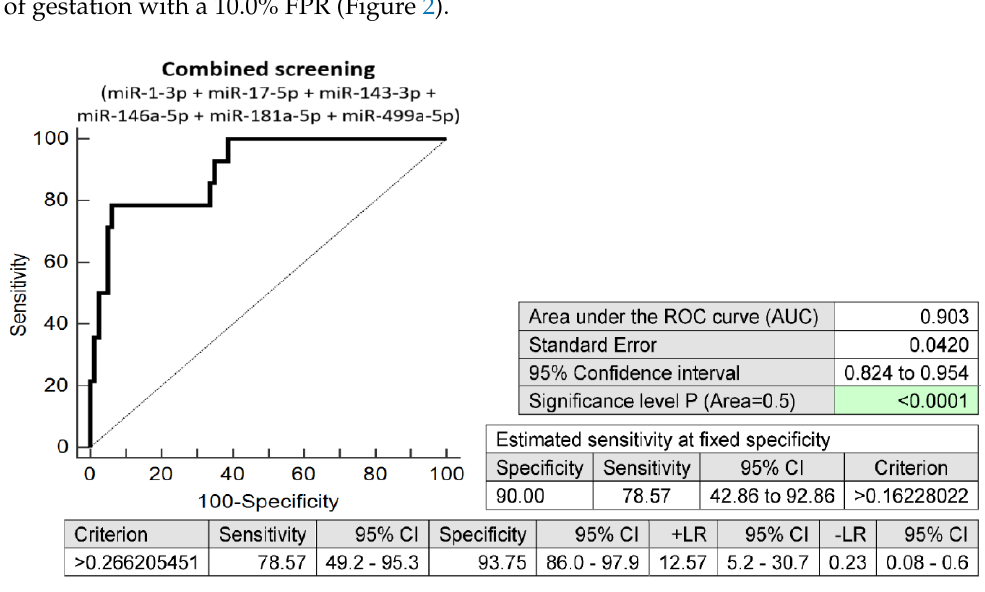
Figure 2. ROC analysis: the combination of six microRNAs only (miR-1-3p, miR-17a-5p, miR-143a-3p, miR-146a-5p, miR-181a-5p, and miR-499a-5p). With a 10.0% FPR, 78.57% of pregnancies developing HELLP syndrome were correctly identified. CI, confidence interval; +LR, positive likelihood ratio; -LR, negative likelihood ratio; FPR, false-positive rate.